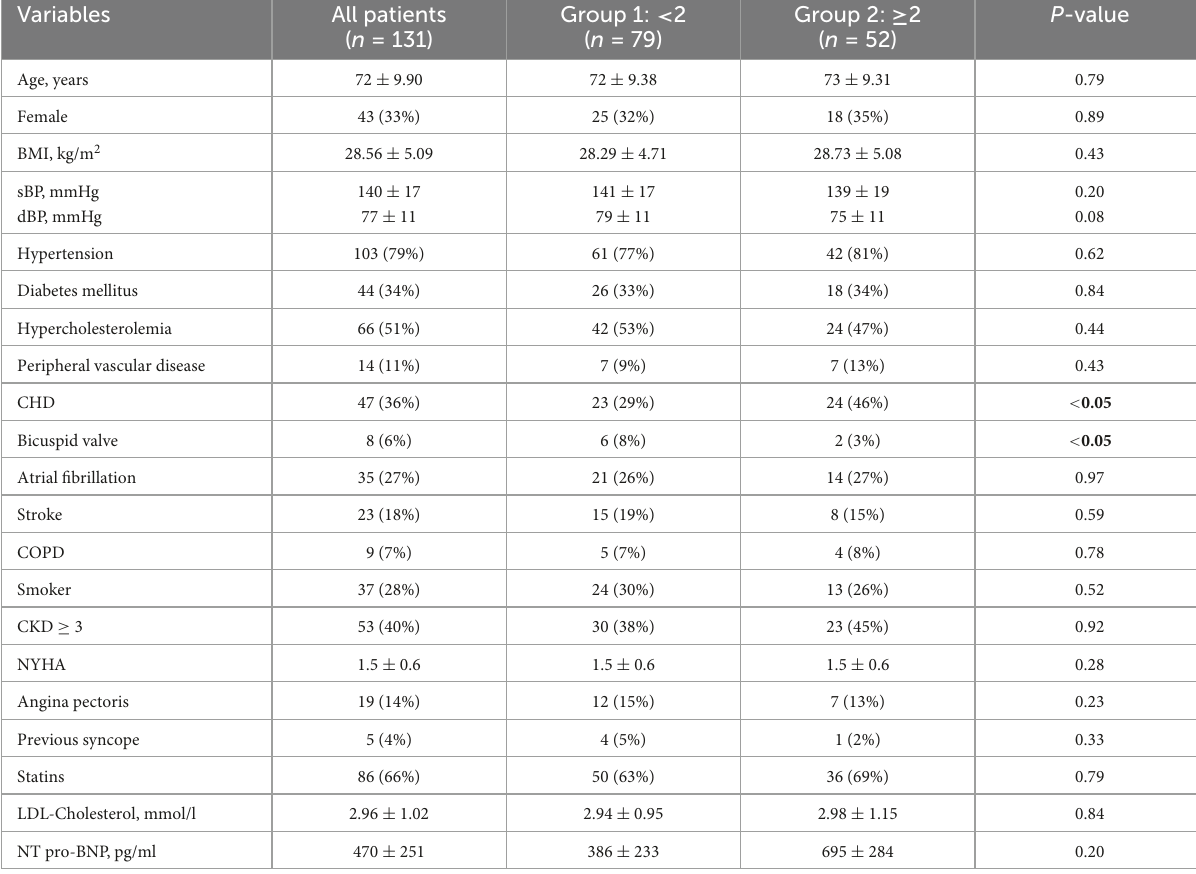
TABLE 1 Baseline characteristics of patients with moderate aortic valve stenosis (AS).